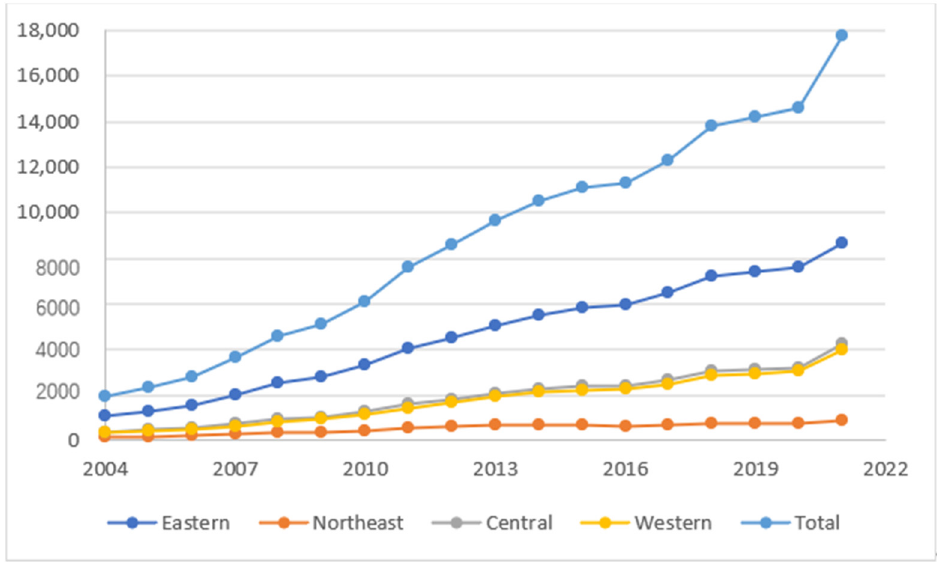
Figure 1. Trends of the GDP in the four regions from 2004 to 2021. Source: China Statistical Year- book.